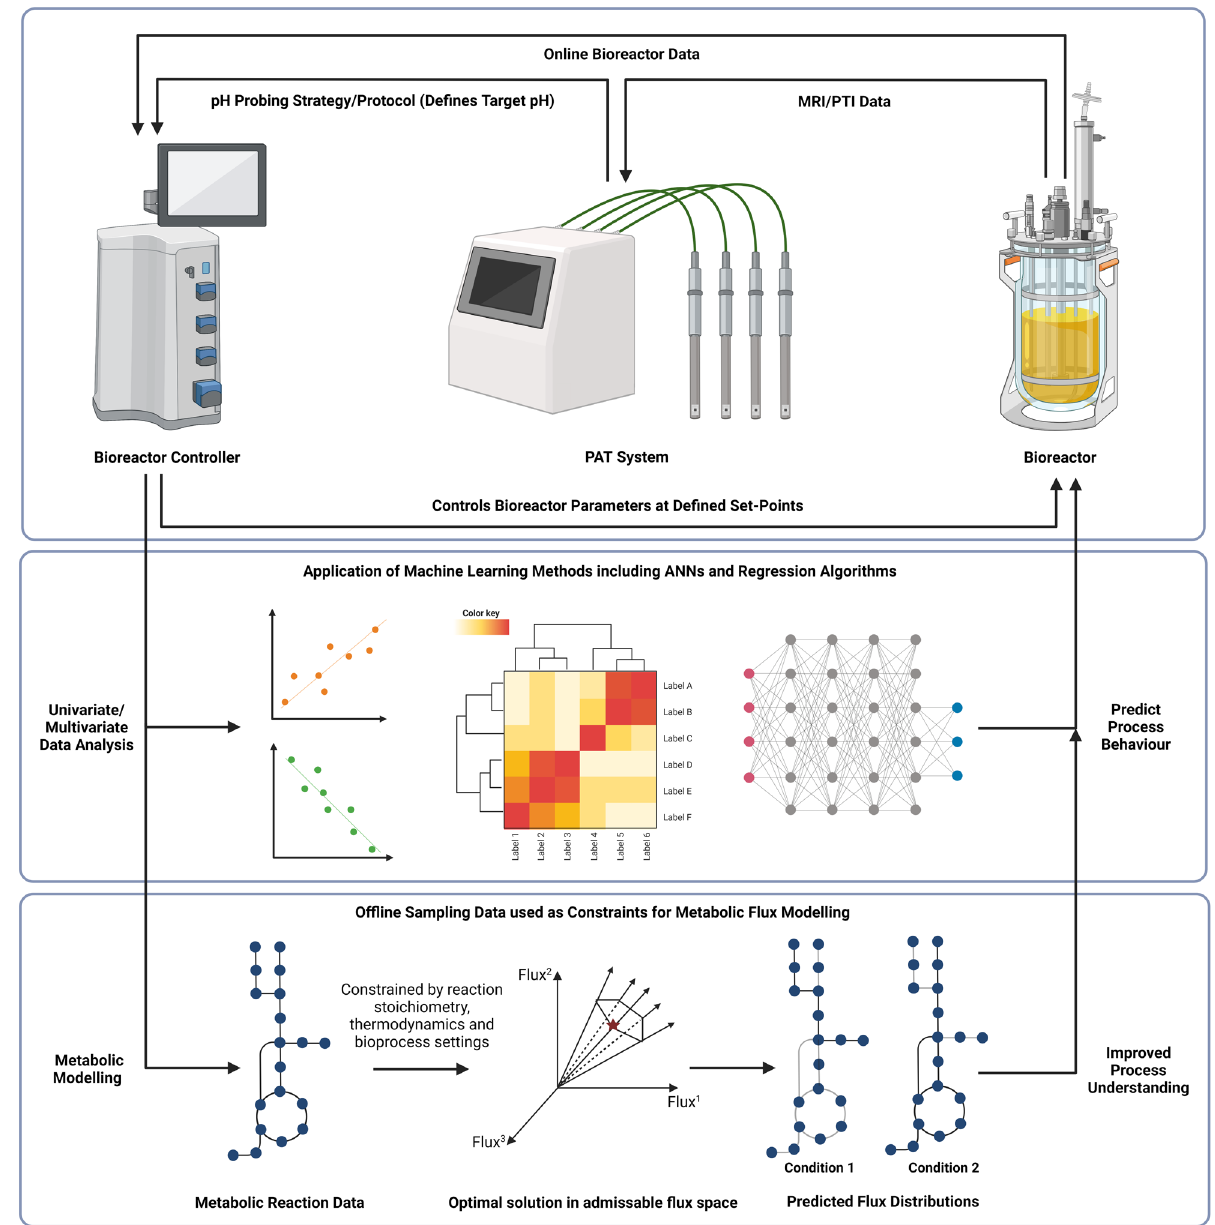
Figure 1. Schematic of the integration of the Ranger RI system with a bioreactor and a bioreactor controller unit. The PAT has the ability to adapt bioprocessing conditions based on the PTI/MRI data collected during an ongoing bioprocess. Figure made using